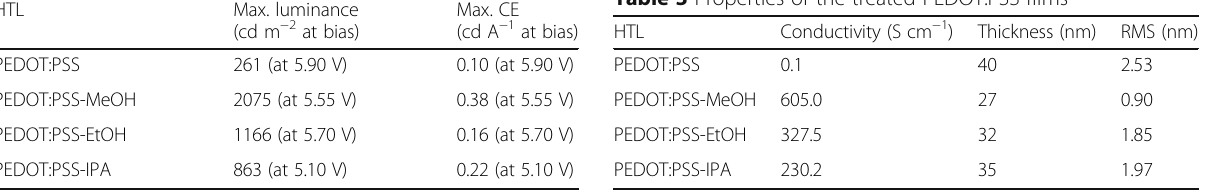
Table 3 Properties of the treated PEDOT:PSS